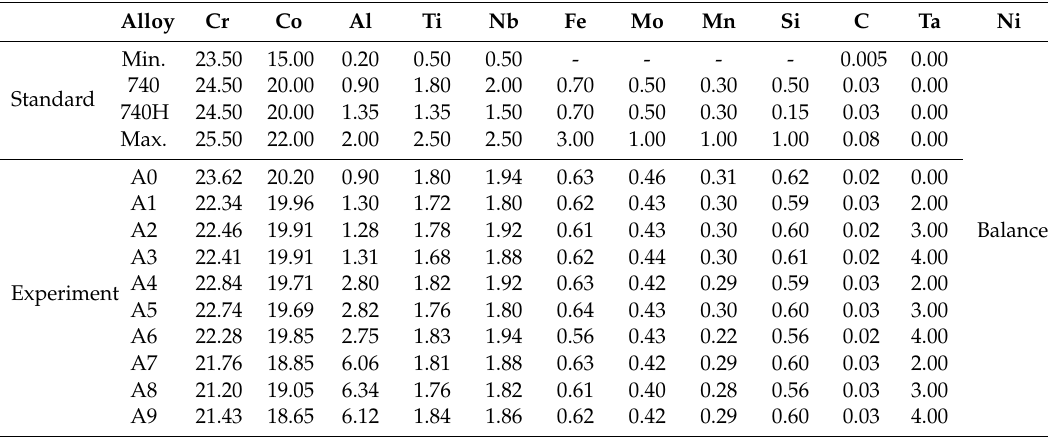
Table 2. The modification of Inconel 740 (wt%).